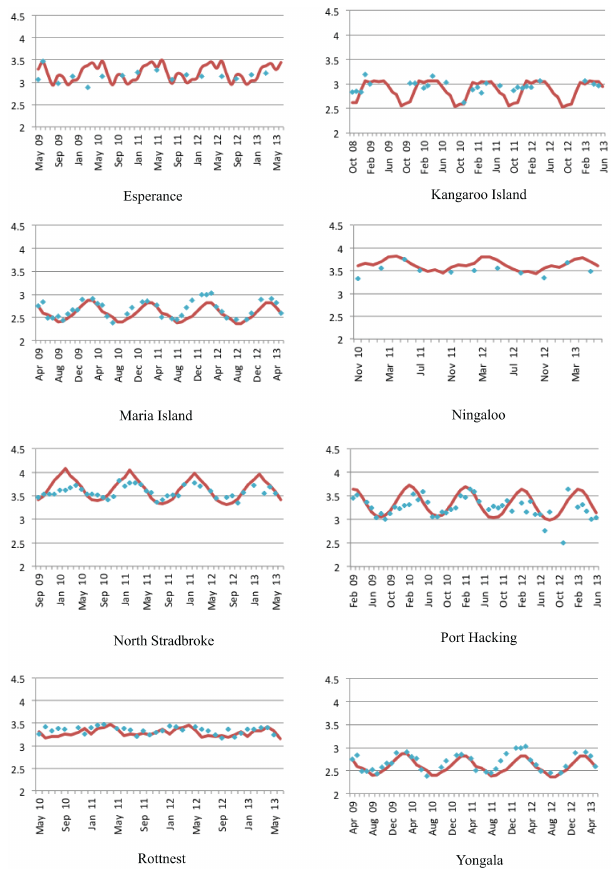
Figure 4. Comparison of aragonite saturation state ( (cid:127) AR ) from the observations at the IMOS National Research Stations with the re- constructed values.